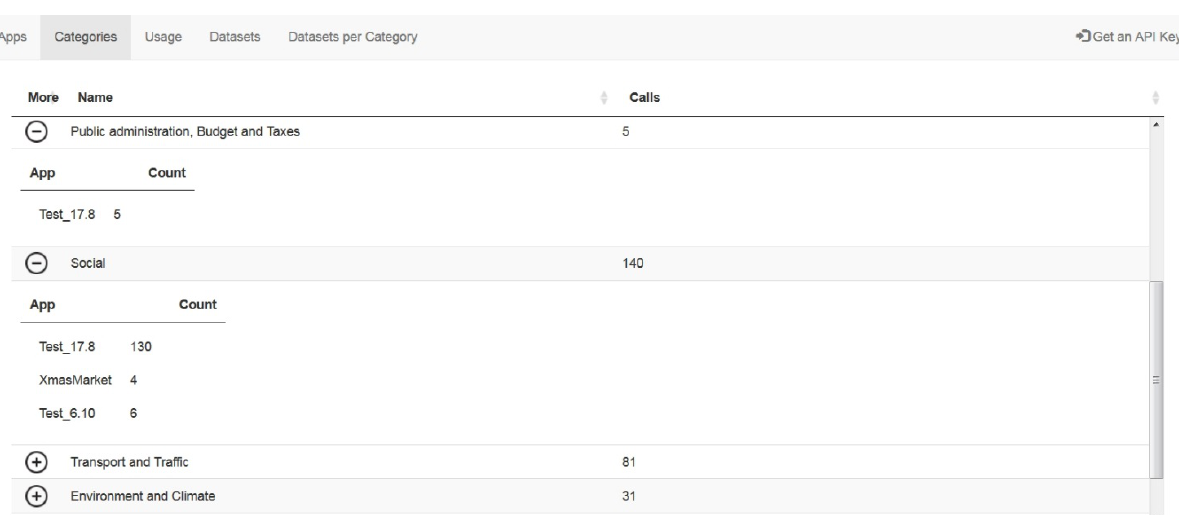
Figure 7: An example of practical use of semantic API - information can be produced about applications which access some types of datasets in a city. Datasets of type 'social' seem to be the most requested in this example; the app Test_17.8 re-uses dataset which are related to the categories 'Public administration, Budget and Taxes', and